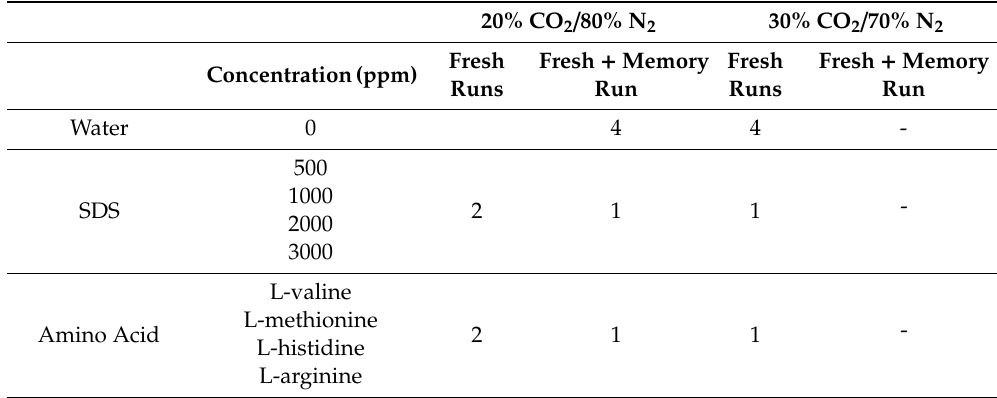
Table 4. Experimental plans for isothermal experiments.